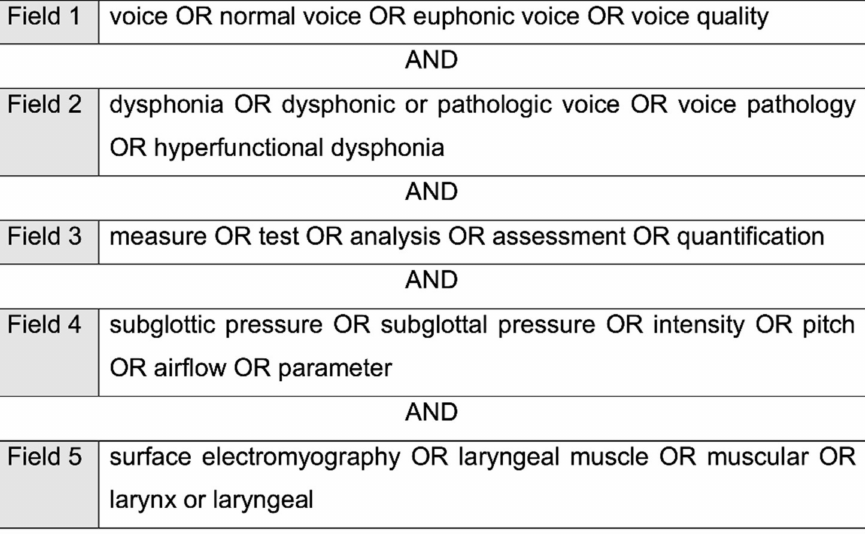
Figure 1. Search strategy